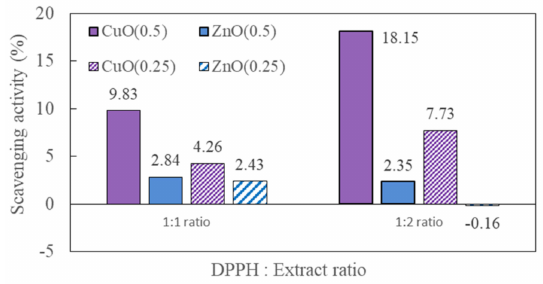
Figure 5. Comparison of DPPH scavenging activity in Lactuca sativa at the exposure of different concentration of CuO and ZnO. CuO(0.5) represents CuO exposure at final concentration 0.5